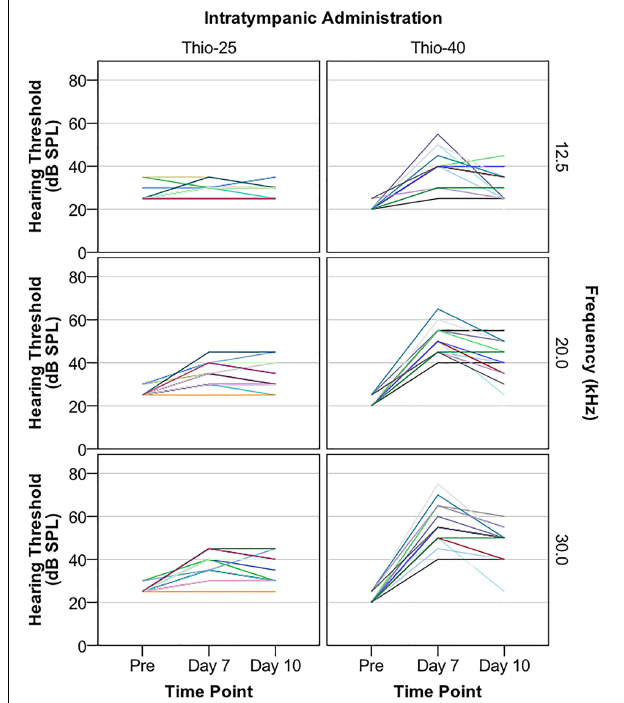
FIGURE 1 | Guinea pigs were subjected to a single, unilateral intratympanic (IT) injection of sodium thiosulfate (100 mM) in a particulate chitosan gel with a gel particle concentration of 25% (Thio-25 group, n = 15) or 40% (Thio-40 group, n = 15). Electrophysiological hearing thresholds assessed with air-conducted acoustically evoked auditory brainstem response (ABR) were measured at 12.5, 20.0, and 30.0 kHz before (pre) and 7 and 10 days after IT administration. Hearing threshold (decibel sound pressure level, dB SPL) vs. time point stratified by IT administration and frequency is shown. Each color represents one animal. Fewer colors than 15 per graph are due to overlapping